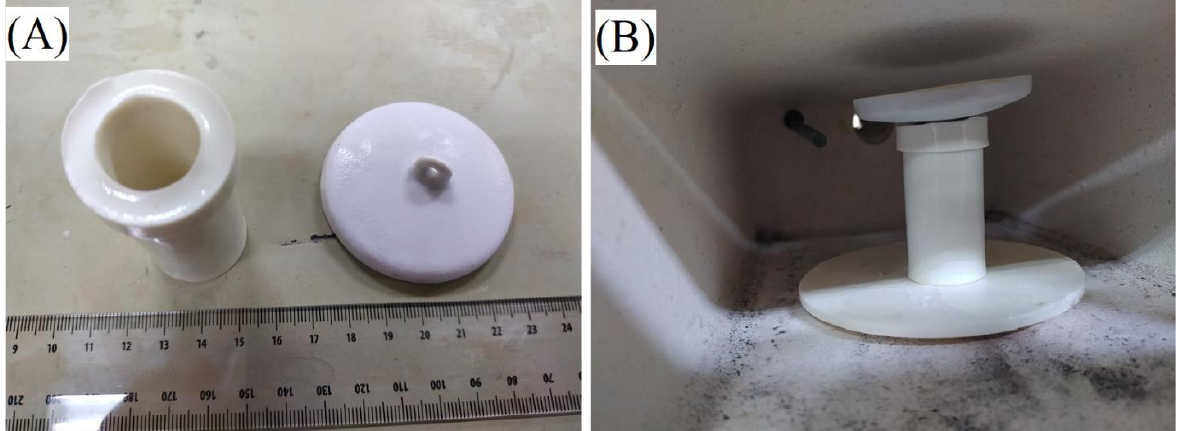
Figure 5. ASH-G composites before ( A ) and after ( B ) filling with Group 1 chloride salts. Amorphous self-healing geopolymer containers were heated with and without Group 1 chloride to ~ 5 °C above their melting points — 805 °C and 775 °C for sodium chloride and potassium chloride, respectively. Both test and control samples were held at these temperatures for 240 h. Once cooled, the ASH-G samples were measured for changes in mass and length. Solidified sodium chloride and potassium chloride samples